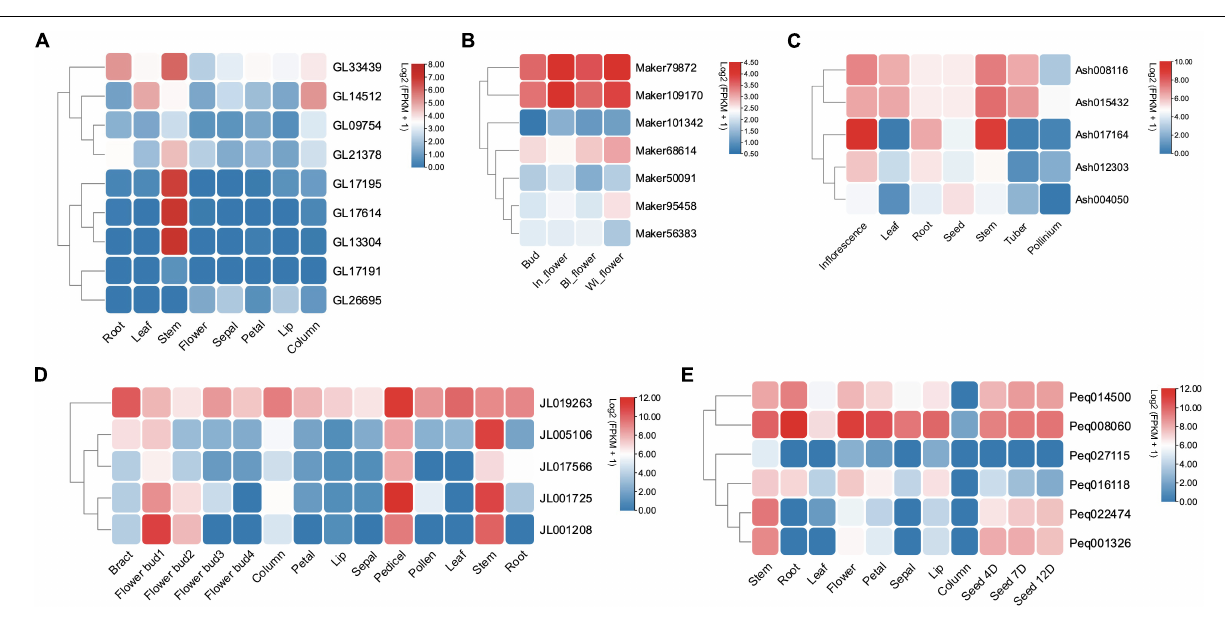
FIGURE 6 | The expression profile of KNOX genes among different tissues in five orchids. (A) C. goeringii. (B) D. chrysotoxum. In_flower, initial opened flower; BI_flower, fully opened flower; Wi_flower, withered flower. (C) A. shenzhenica. (D) C. ensifolium. Flower bud1, flower bud at an early stage; Flower bud2, flower bud at the middle stage; Flower bud3, flower bud at a late stage. (E) P. equestris. Seed 4D, 4 day’s seed; Seed 7D, 7 day’s seed; Seed 12D, 12 day’s